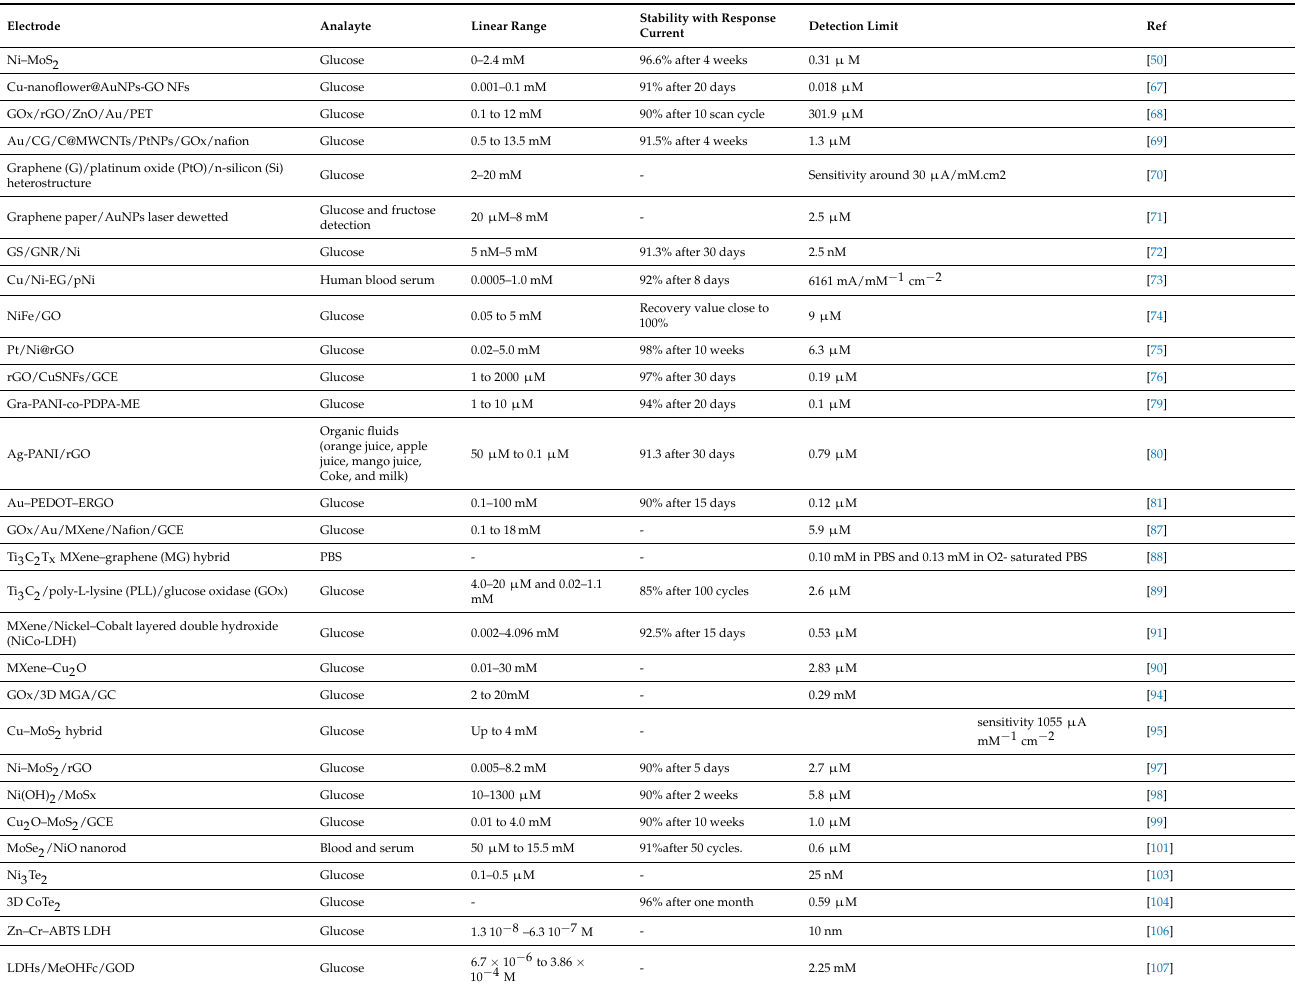
Table 4. Overview of electrochemical glucose sensors based on two-dimensional materials for glucose